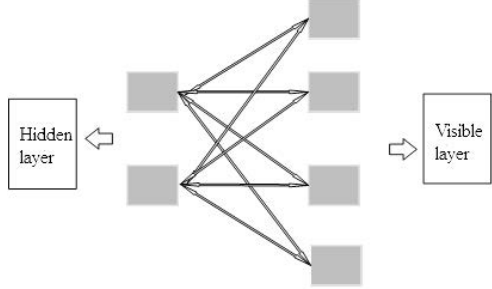
Fig. 1 RBM network structure. RBM, restricted Boltzmann